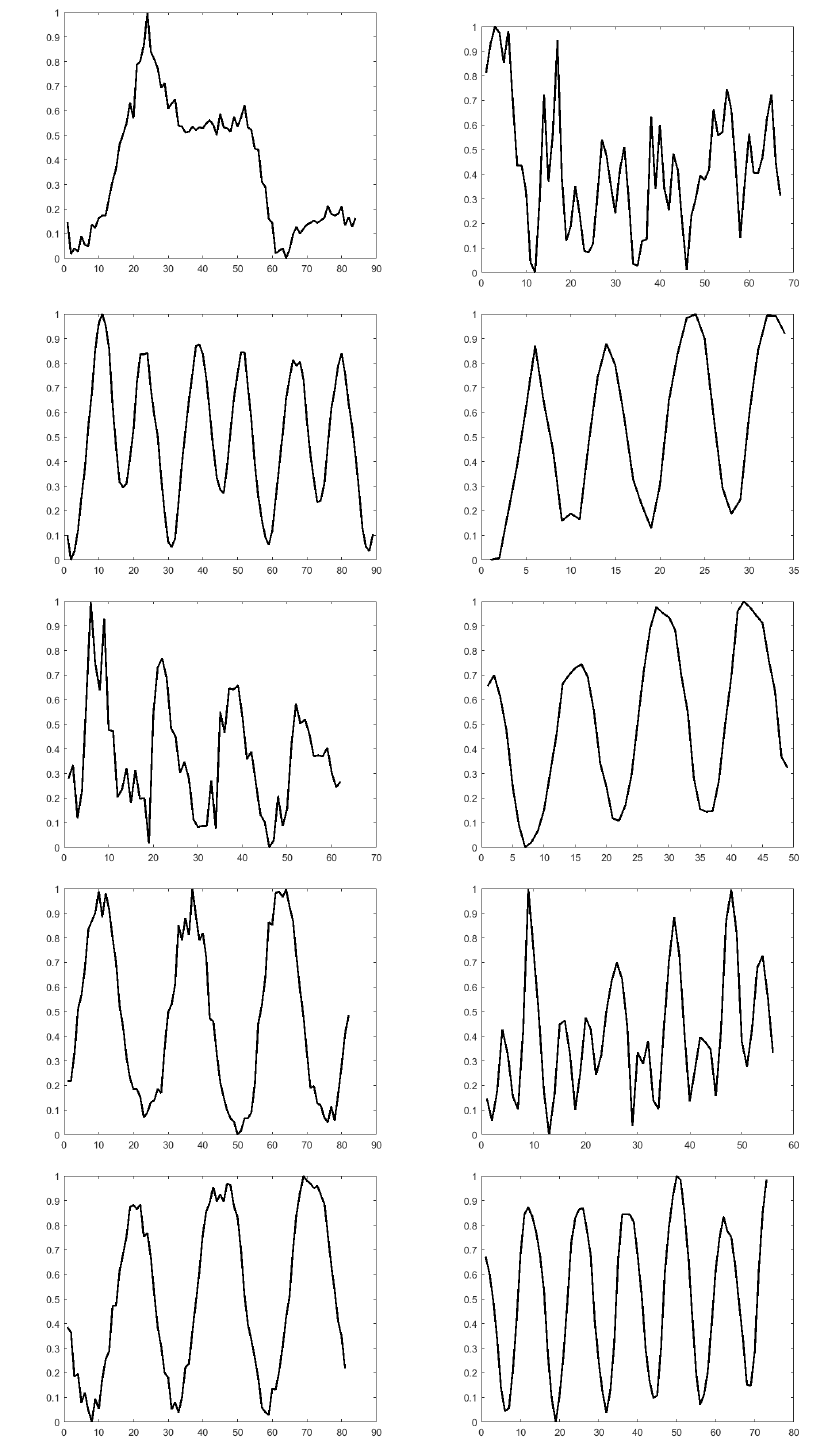
Figure 3. Line graphs showing normalized area values for actions presented in Figure 2. The X axis corresponds to the consecutive frame numbers, while the Y axis corresponds to the normalized area values of the foreground object in each frame. Line graphs in the left column correspond to the actions performed in place (bending, jumping-jack, jumping in place, one-hand waving and two-hand waving), and line graphs for actions with changing location of a silhouette are depicted in the right column (jumping forward, running, galloping sideways, skipping and